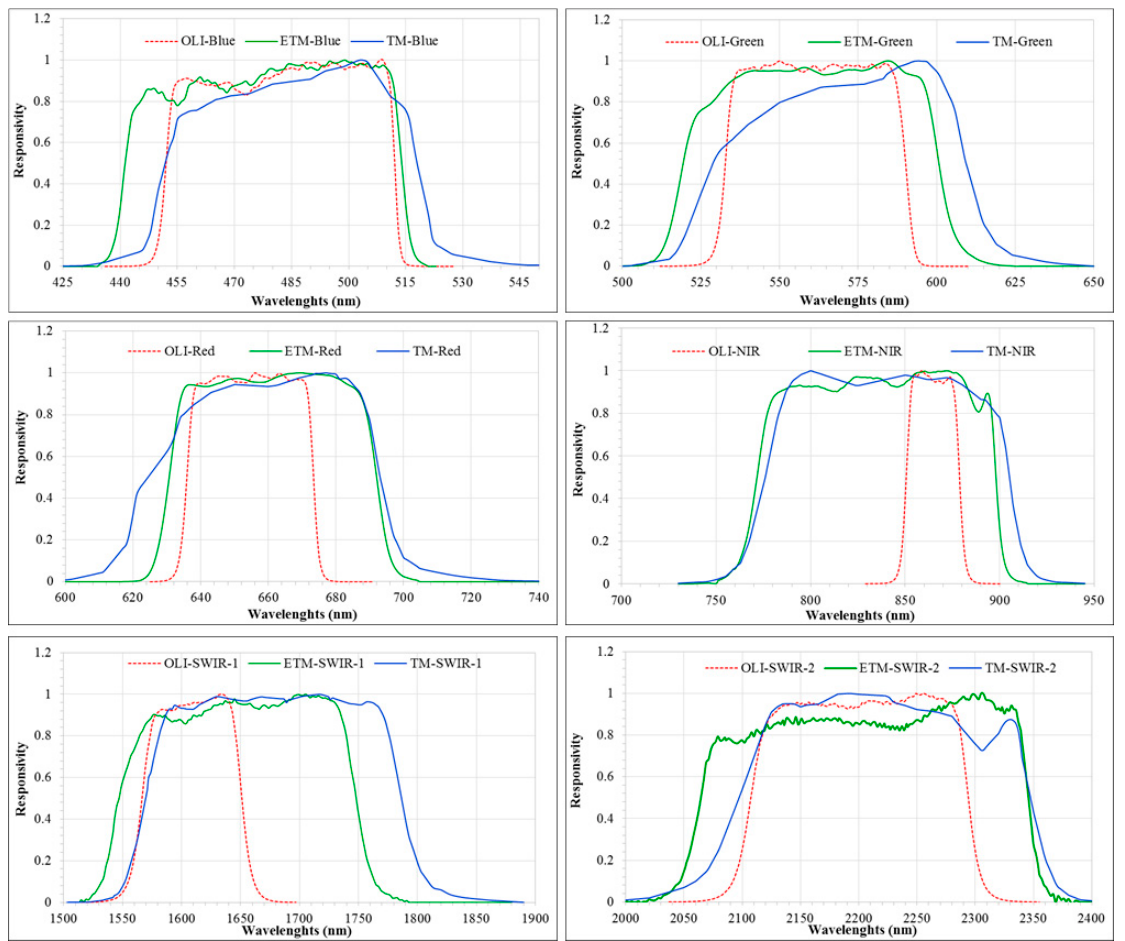
Figure 4. Spectral response profiles of Operational Land Imager (OLI) Enhanced Thematic Mapper Plus (ETM+) and Thematic Mapper (TM) Landsat sensors.